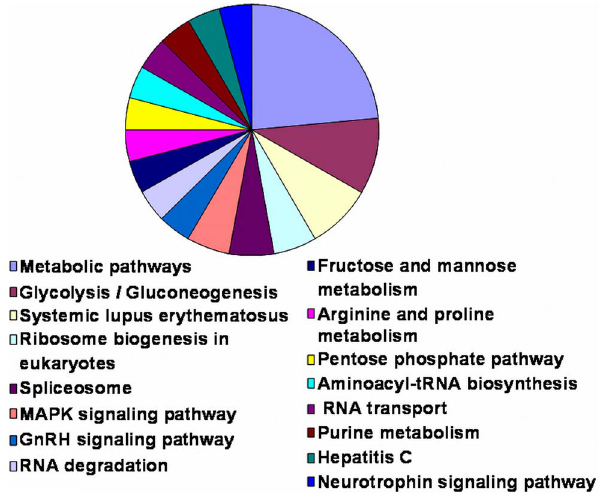
Figure 5. KEGG pathway analysis of genes distinguishing cells grown in 2D and lrECM culture conditions. Shown are all categories (pathways/hits) represented by three or more differently regulated genes when comparing 2D and lrECM 3D culture conditions.